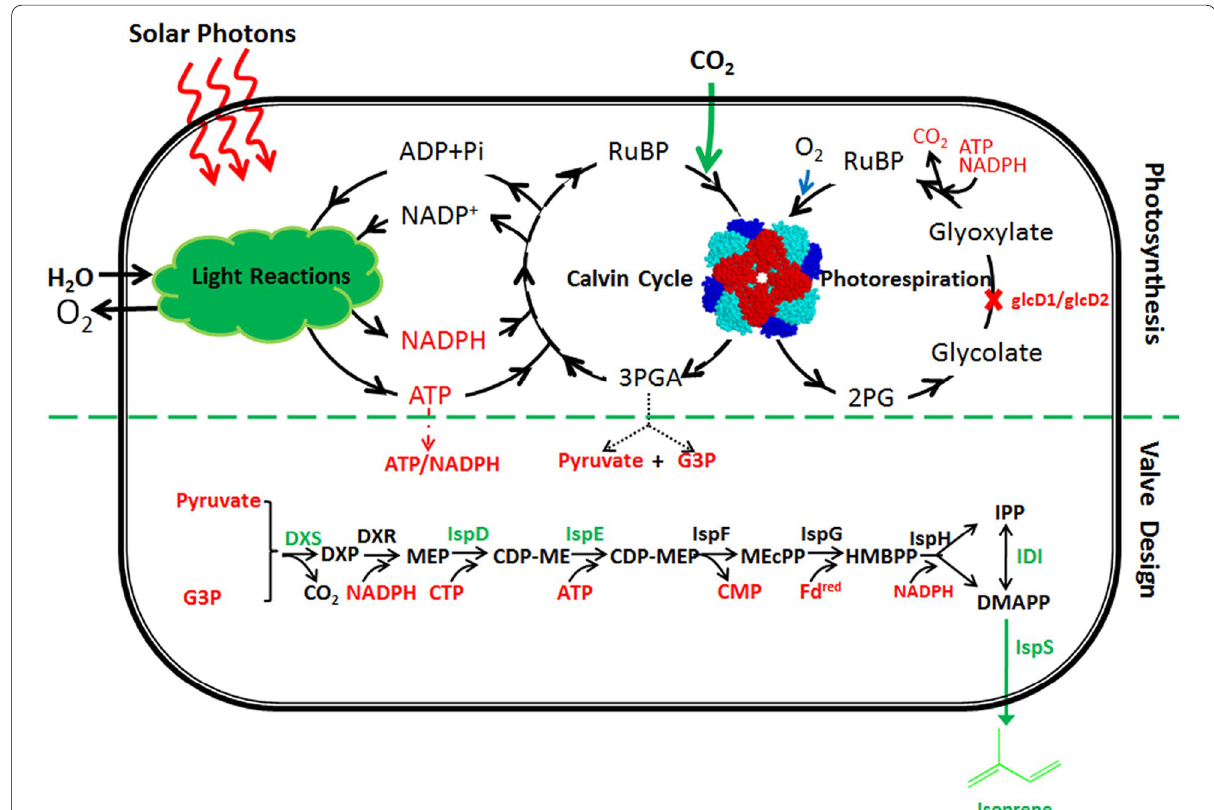
Fig. 1 Design and creation of an isoprene synthetic pathway in Synechocystis . The isoprene synthetic pathway is a MEP-dependent and energy consuming pathway. An exogenous isoprene synthase (IspS, from Pueraria montana ) was introduced to convert DMAPP to isoprene. To optimize the isoprene-synthetic pathway, dxs , idi , ispD and ispF from E. coli were overexpressed in Synechocystis . RuBP ribulose-1,5-bisphosphate, 3PGA 3-phosphoglycerate, 2PG 2-phosphoglycolate, G3P glyceraldehyde-3-phosphate, DXP 1-deoxy- d -xylulose-5-phosphate, MEP methylerythritol phosphate, CDP-ME diphosphocytidylyl methylerythritol, CDP-MEP diphosphocytidylyl methylerythritol 2-phosphate, MEcPP methylerythritol 2,4-cyclodiphosphate, HMBPP hydroxymethylbutenyl 4-diphosphate, IPP isopentenyl pyrophosphate, DMAPP dimethylallyl pyrophosphate. Enzymes: DXS DXP synthase, DXR DXP reductoisomerase, IspD 4-diphosphocytidyl-2C-methyl- d -erythritol synthase, IspE 4-(cytidine-5 ′ -diphosp ho)-2-C-methyl- d -erythritol kinase, IspF 2C-methyl- d -erythritol 2,4-cyclodiphosphate synthase, IspG 4-hydroxy-3-methylbut-2-enyl-diphosphate synthase, IspH HMBPP reductase, IDI IPP isomerase, IspS isoprene